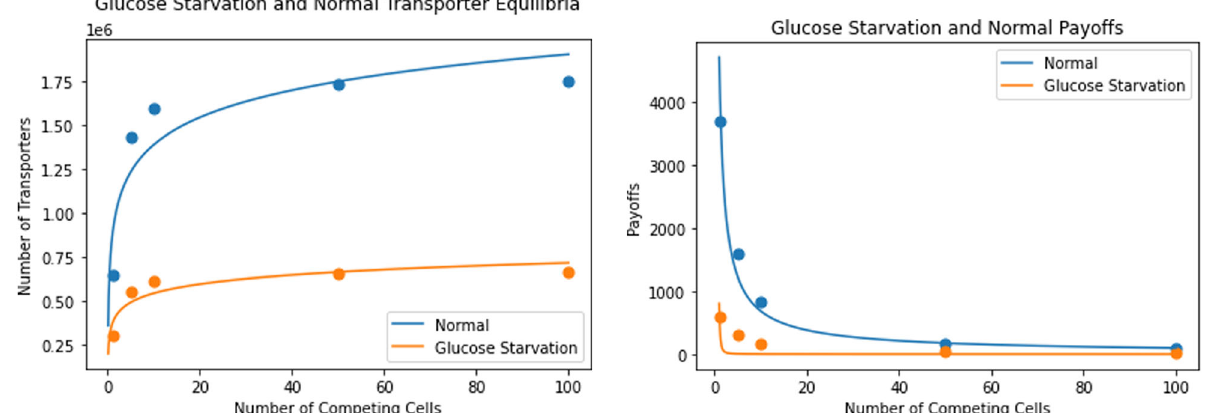
Fig. 7 Glucose starvation vs normal transporter equilibria and payoffs. The left panel plots the number of transporters at ESS as a function of the number of neighboring cells. The right panel plots ESS payoff as a function of neighboring cells. Glucose-starved cancer cells produce fewer transporters and have a lower payoff than cancer cells in normal